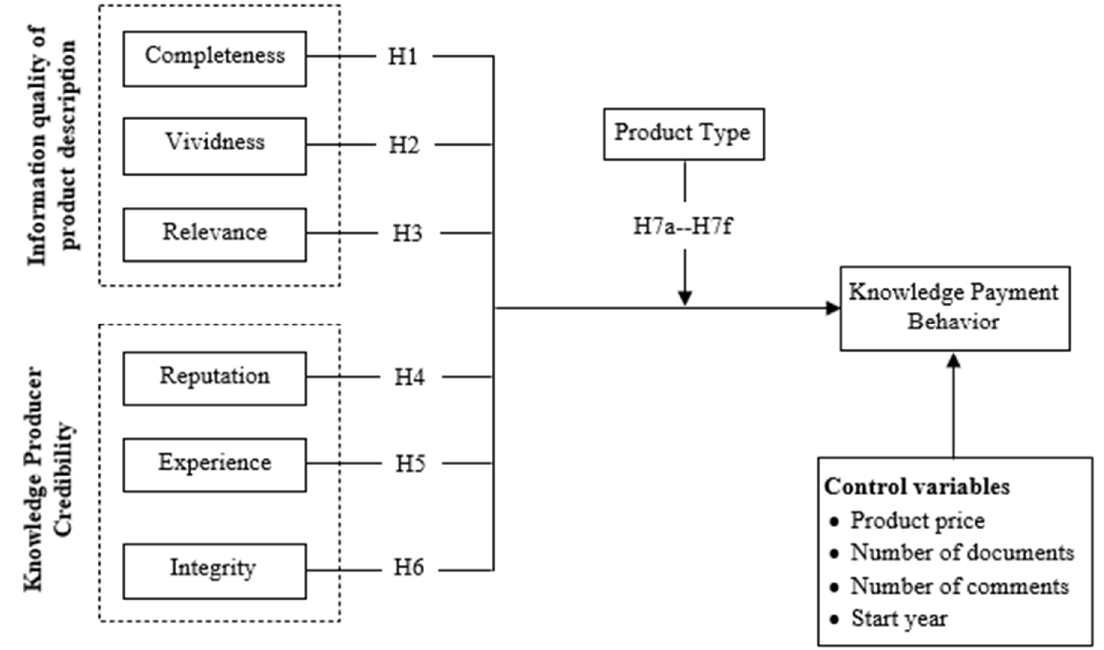
Figure 1. Research model.